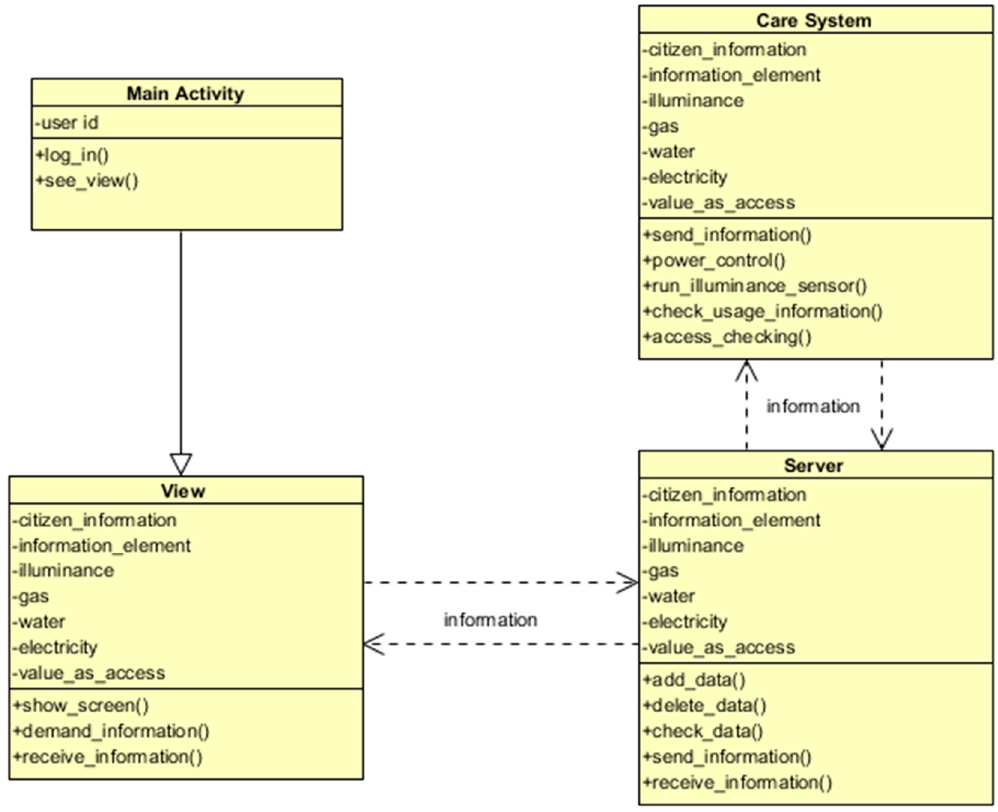
Figure 13. The Entire Java Android-implemented UML of the Framework of Solitary Senior Citizens Monitoring System.